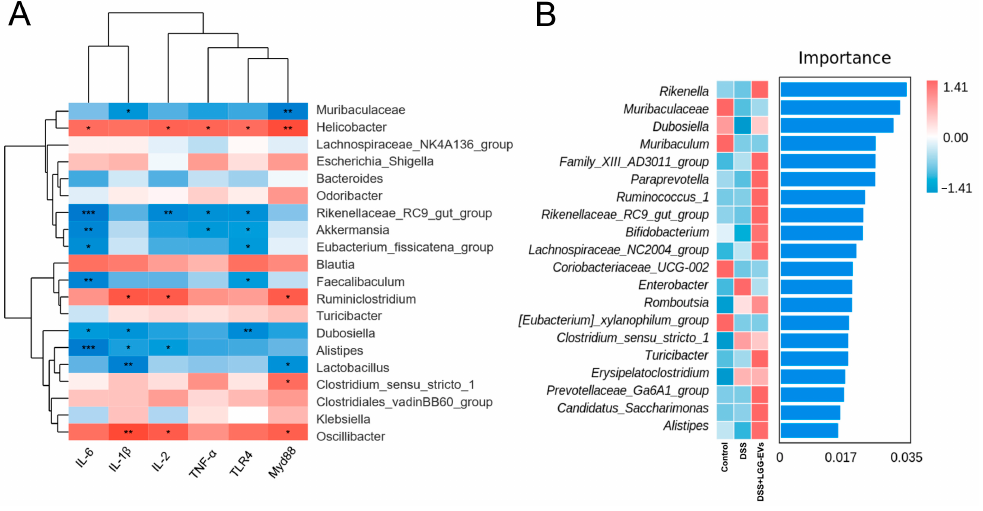
Figure 7. Interrelationship between gut microbiota and intestinal immune-inflammatory factors. ( A ) Heatmap of Spearman’s correlation between gut bacteria (at the genus level) and inflammatory factors. Significant difference determined at * p < 0.05, ** p < 0.01, *** p < 0.001. ( B ) Analysis of the bacterial profile discrepancies among three groups using random forest.